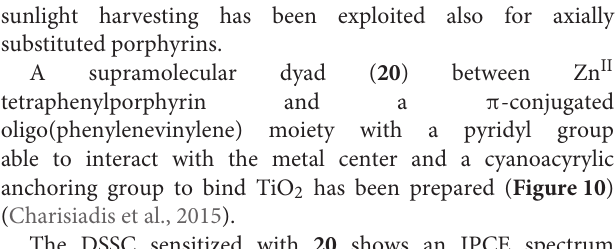
of the B band appears (at 464 nm for 18 and at 471 nm for 19 ), more bathochromically shifted for 19 , in accordance to the more electron-acceptor nature of BTD with respect to